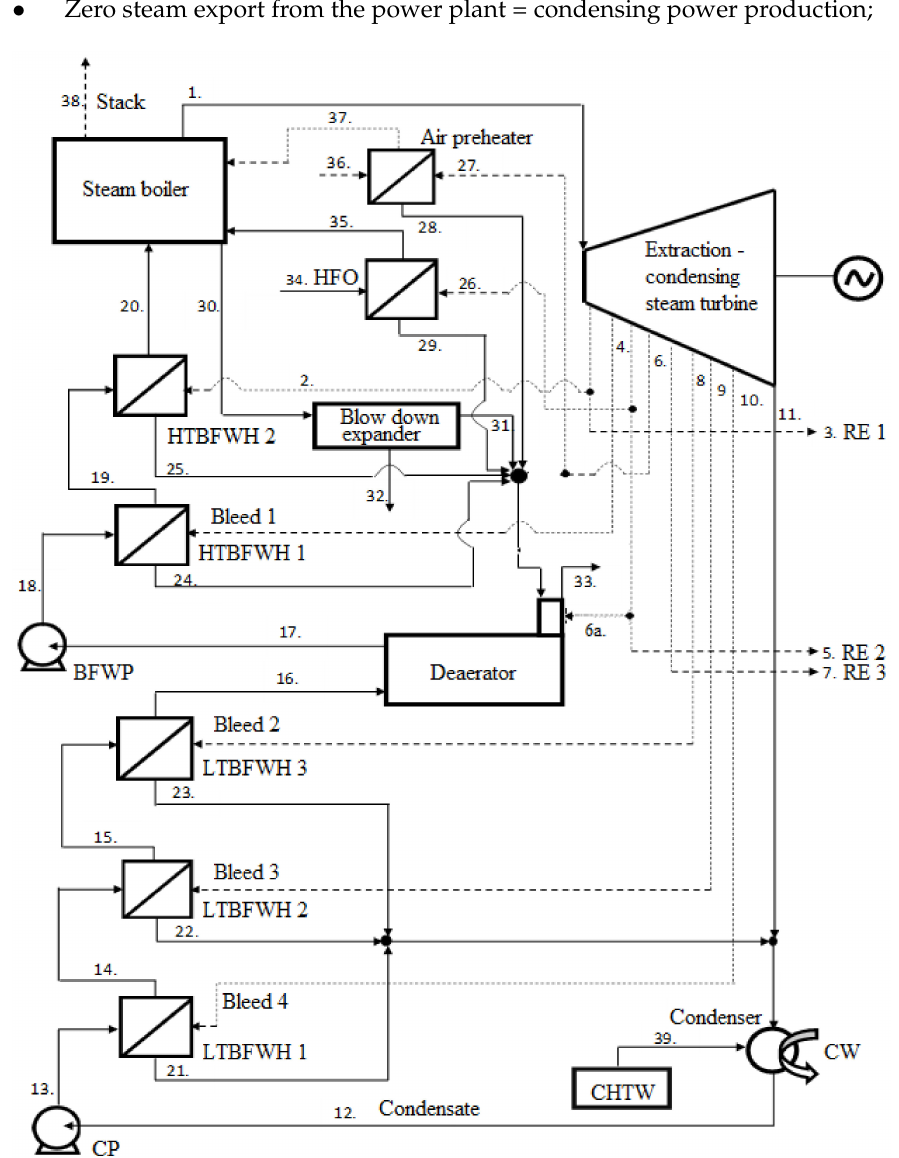
Figure A2. Model industrial thermal power plant. BFWP—boiler feedwater pump; CP—condensate pump; CHTW—chemically treated water; CW—cooling water; HFO—heavy fuel oil; HTBFWH— high-temperature boiler feedwater heater; LTBFWH—low-temperature boiler feedwater heater; RE—regulated extraction. Source: own